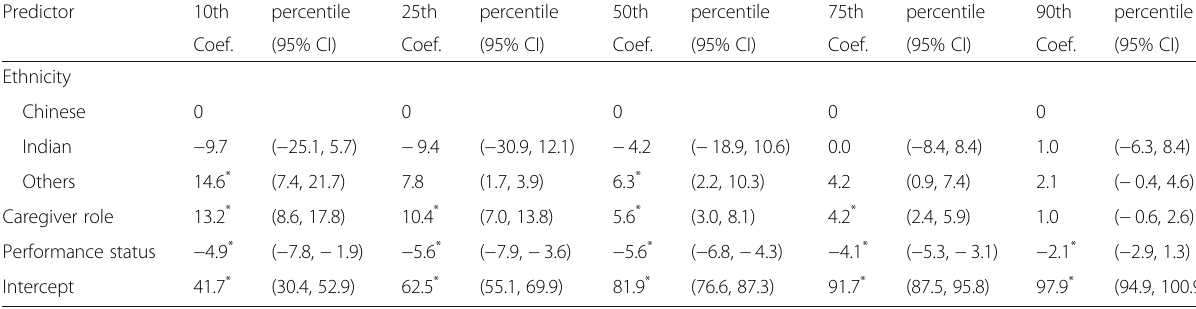
Table 4 Percentiles of QOL Physical Well-being score, final model Predictor 10th percentile 25th percentile 50th percentile 75th